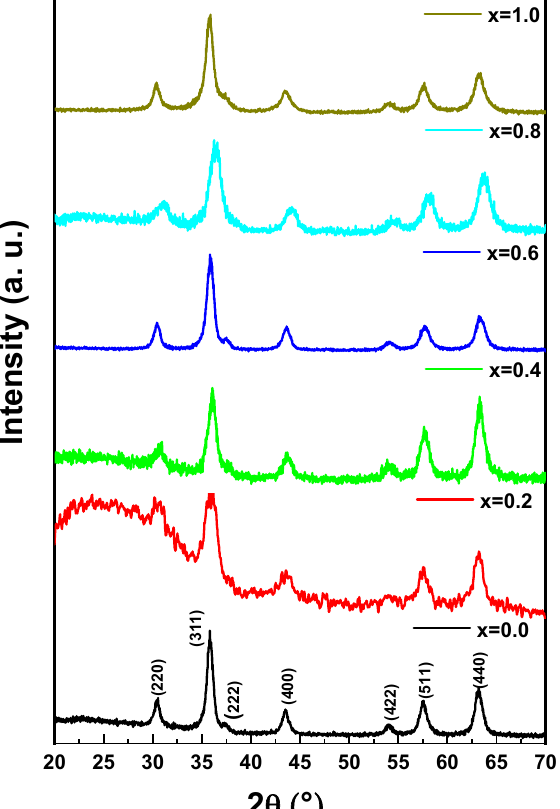
Figure 1. XRD powder patterns of Co 0.5 Ni 0.5 Ga x Fe 2 − x O 4 (0.0 ≤ x ≤ 1.0) MCs.